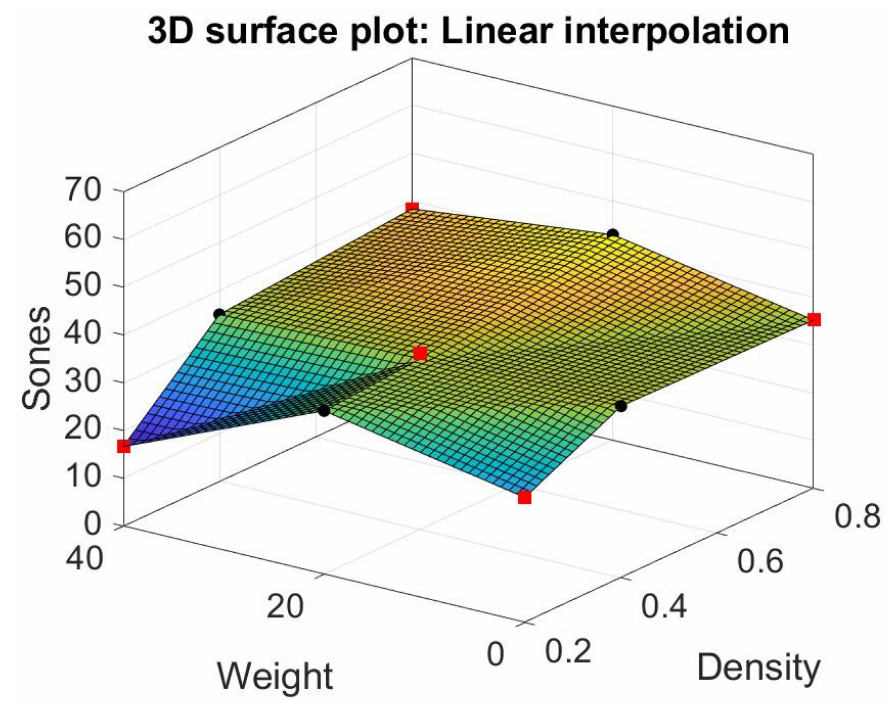
Figure 14. Linear interpolation.